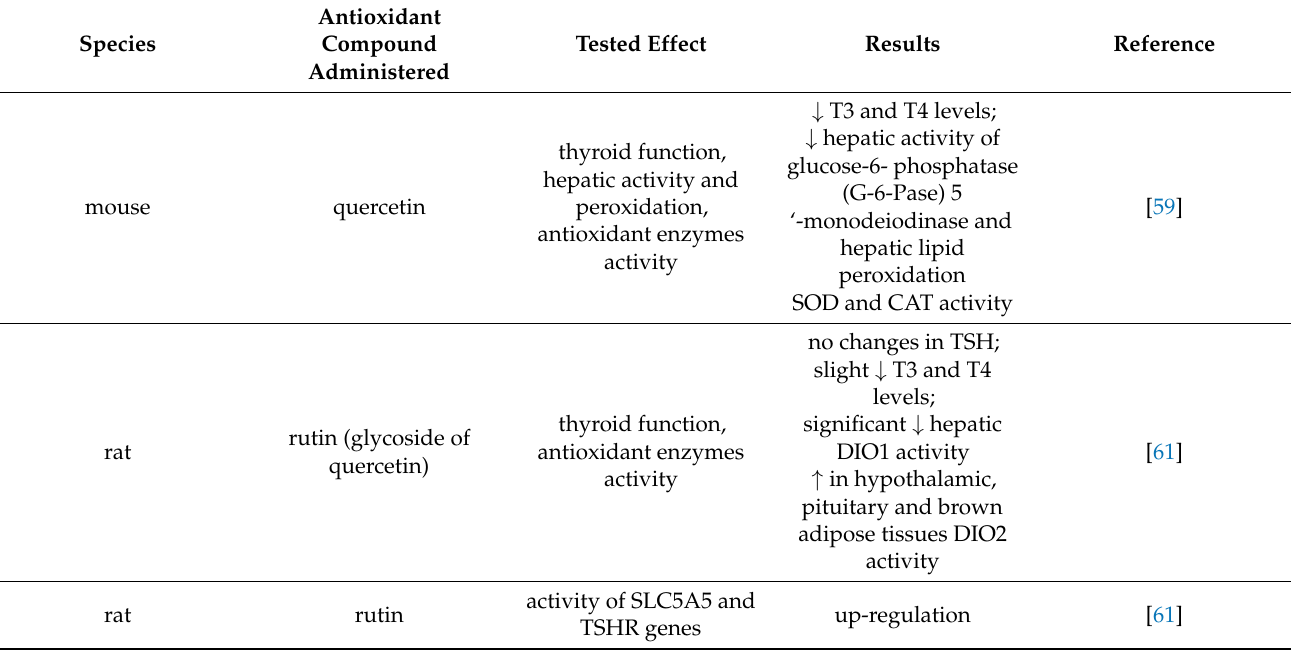
Table 5. Effects of quercetin and rutin supplementation on biochemical and redox status of hyperthyroid-induced animal models.